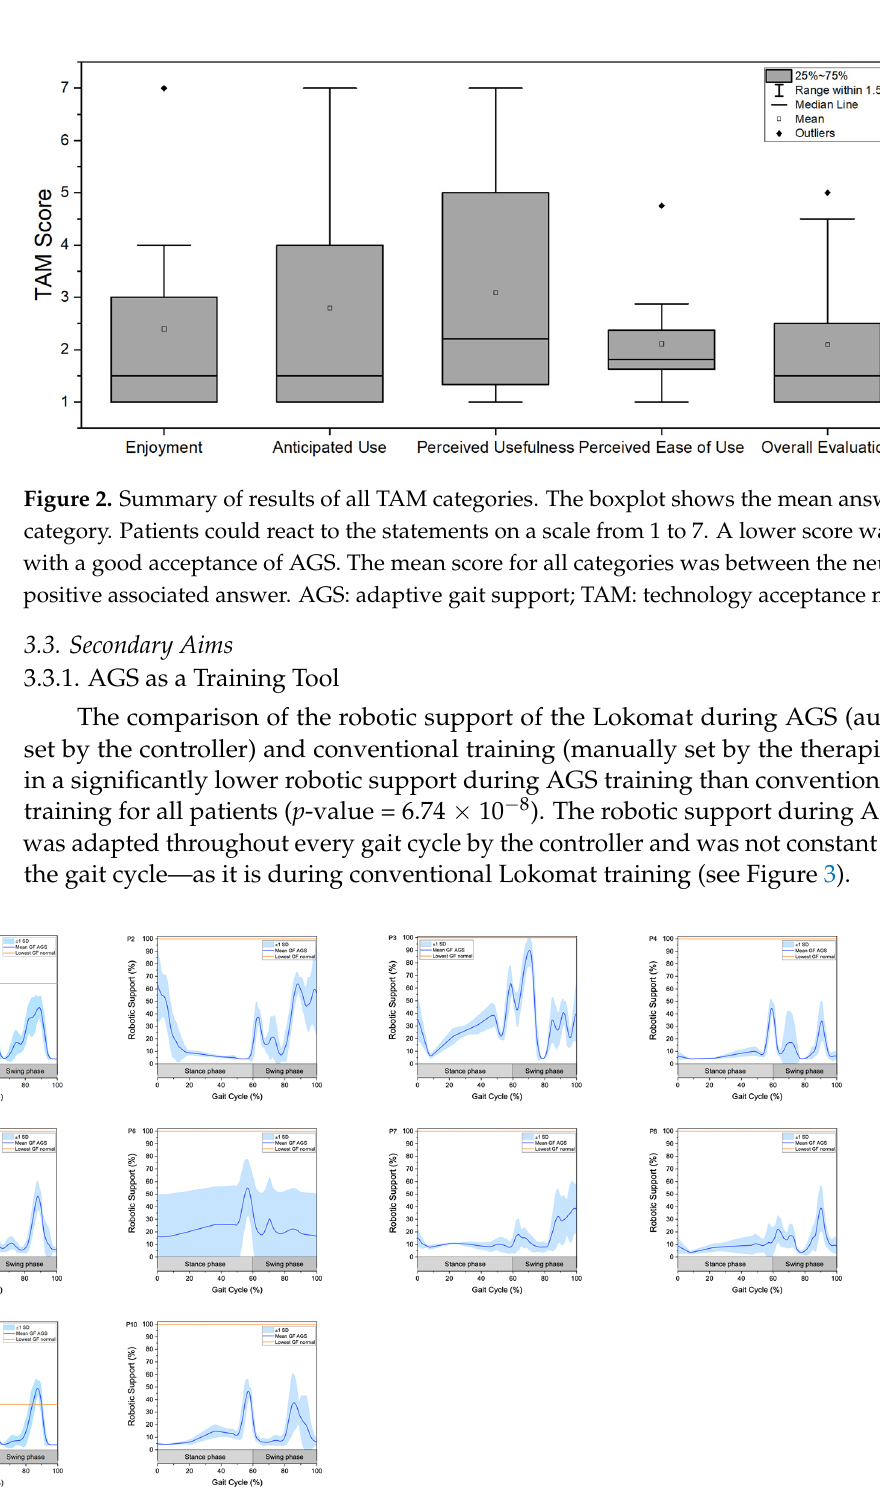
Figure 3. Robotic support (normalized stiffness averaged among hip and knee) over the gait cycle for all patients during one session of AGS training. The blue line indicates the mean robotic support of the 100th step of one leg (the better leg of the patient), for every training session of this patient. The 100th step was chosen because for every patient it was performed after the plateau in robotic support was reached. Light blue shows ± 1 standard deviation (SD) over the total amount of gait cycles which were conducted for 4 min. The orange line represents the lowest robotic support value the therapist set for this patient throughout the study